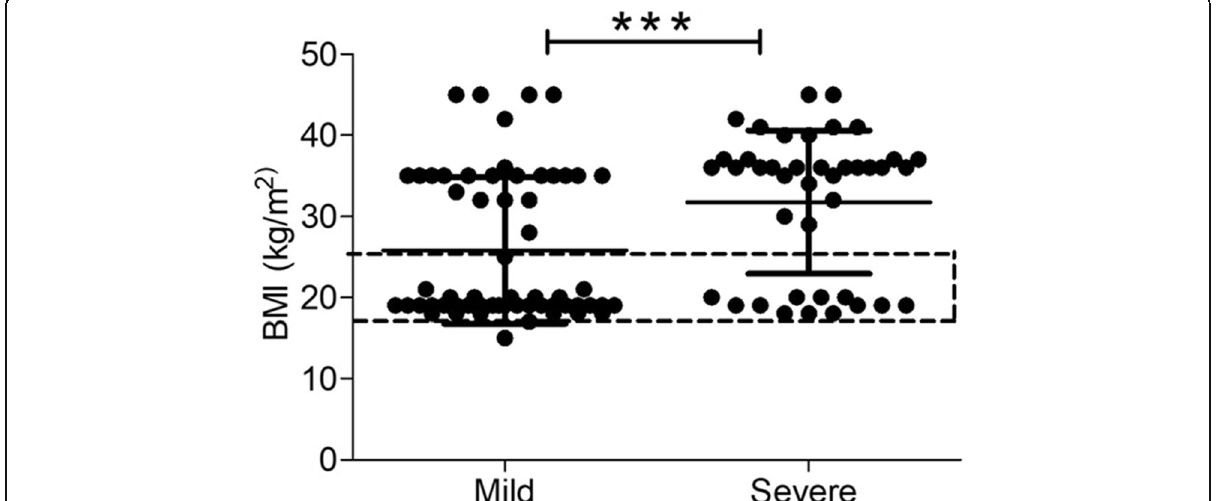
Fig. 1 Comparison of body mass index (BMI) between the two studied groups. BMI of patients from the mild group ( N = 59) and severe group ( N = 41). The median and interquartile range is shown with horizontal lines. The dashed box represents the normal range for BMI in healthy individual (18.9 – 25 kg/m 2 ). *** p <